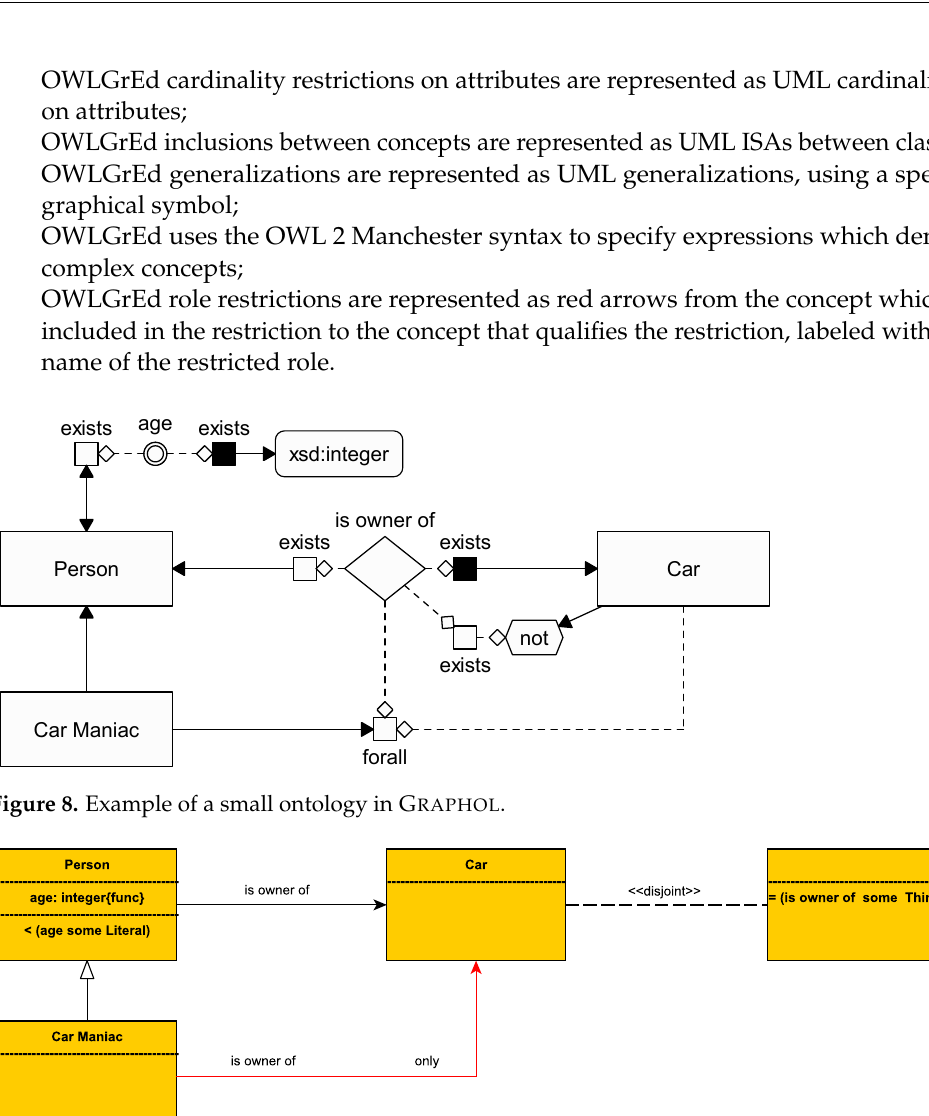
Figure 9. Example of a small ontology in